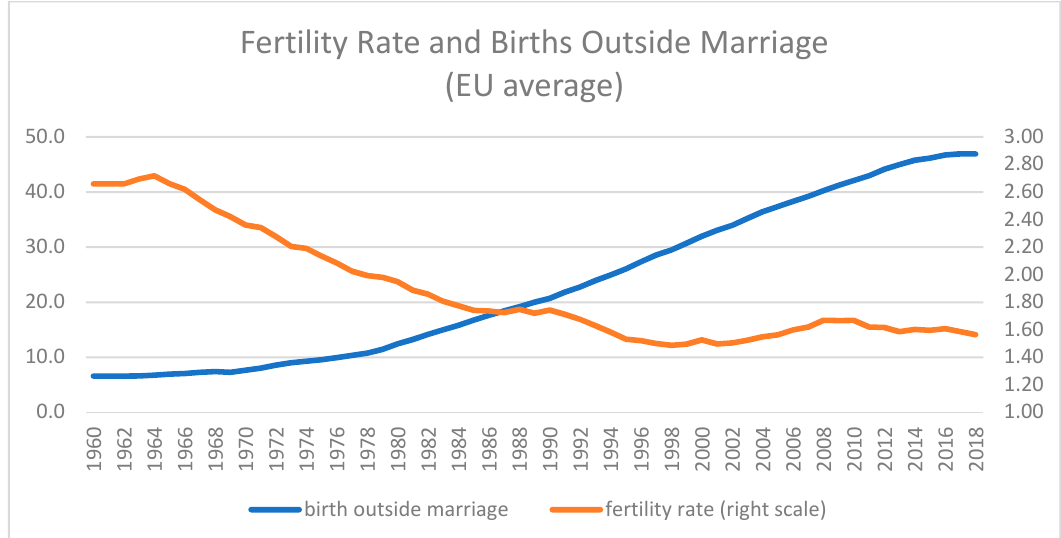
Figure 3. Source: our elaboration on Eurostat data. Countries: Austria, Belgium, Bulgaria, Czech Republic, Denmark, Finland, France, Germany, Greece, Hungary, Iceland, Ireland, Italy, Latvia, Luxembourg, Netherlands, Norway, Portugal, Slovak Republic, Slovenia, Spain, Sweden, United Kingdom.